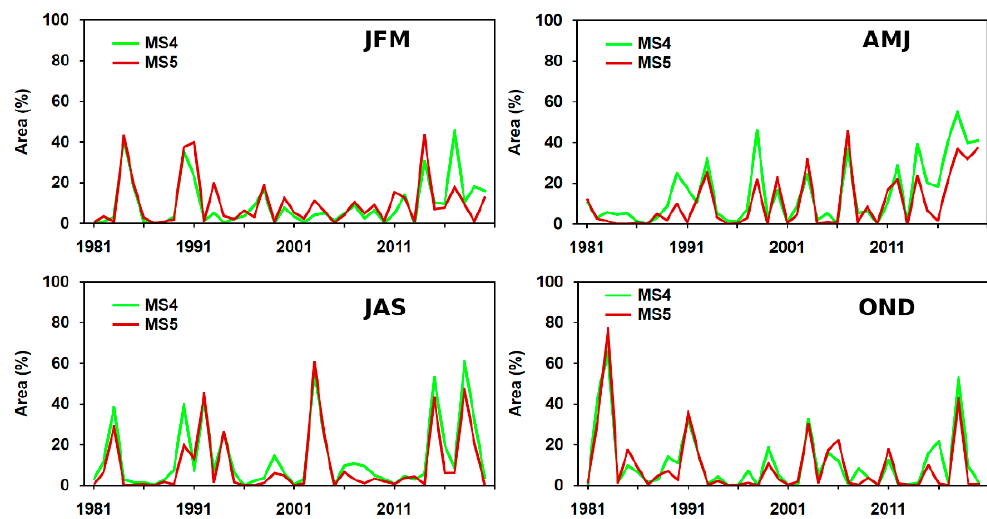
Figure 8. Fluctuations in the area with 10th-percentile soil drought (% of grid points) according to model setups MS4 and MS5 for JFM, AMJ, JAS, and OND in the Czech Republic during the 1981–2020 period. Table 4. Linear trends in the area of 10th-percentile soil drought (% of grid points per 10 years) in the 0–100-cm soil layer according to model setups MS4 and MS5 and Pearson correlation coefficients between MS4 and MS5 for JFM, AMJ, JAS, OND, SHY, and WHY in the Czech Republic during the 1981–2020 period. Statistically significant trends, at a 0.05 significance level, appear in bold